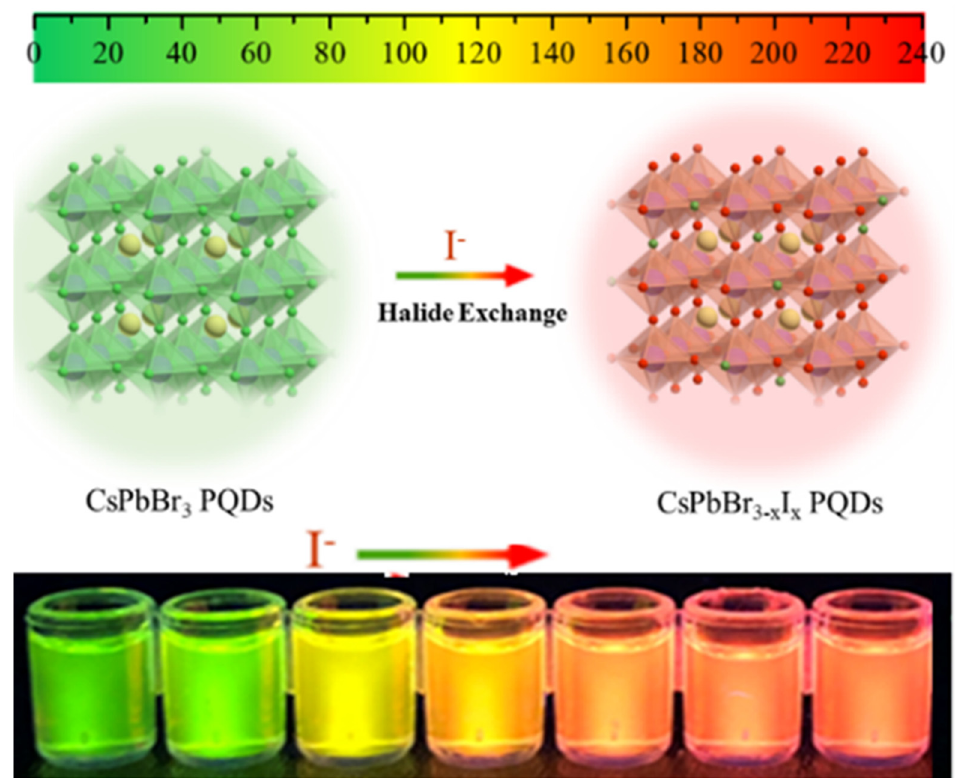
Figure 1. Schematic illustration of the fluorescent color based on the ion exchange of CsPbBr 3 PNCs induced by iodide (left side) and the appearing colors.